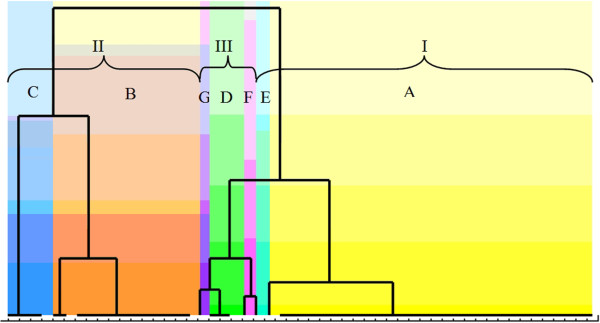
Dendrogram with marked
S. mutans
biotypes.